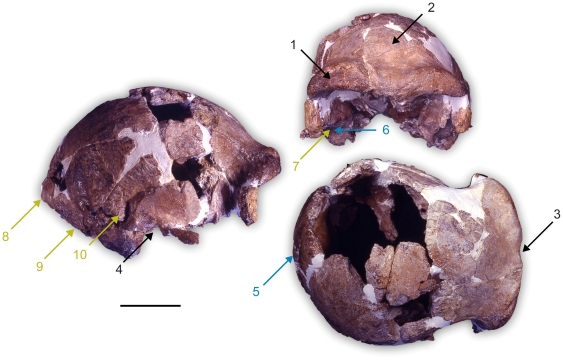
Statistically significant traits that describe the Mid-Pleistocene cluster including Ceprano.Numbers represent the following morphological features: Features 1 to 4 (black) traits that are more exclusive of Mid-Pleistocene specimens (i.e. 1: incomplete sulcus supraorbitalis, 2: frontal tuber weakly developed medially shifted, 3: supraorbital region medially concave, 4: intermediate position of the external auditory meatus in regard to the processus zygomaticus temporalis); 5 and 6 (blue)  =  more derived traits (i.e. 5: straight torus occipitalis transversus, 6: medio-lateral concavity of the articular tubercle); 7 to 10 (green)  =  more primitive traits (i.e. 7: petro-tympanic crest orientated downward, 8: opisthocranion coincident with inion, 9: processus retromastoideus, 10: torus angularis parietalis). Pertinence criterion for statistical significance: T-values>2, p<0.05. Scale bar  = 50 mm.